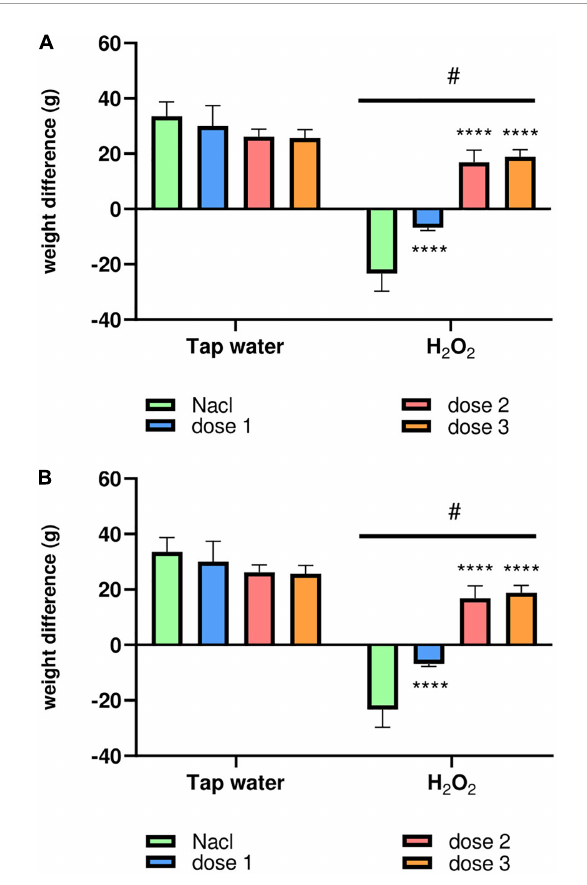
FIGURE3 The animals’ body weight variation during the test period. (A) The kinetics of the average body weight of the different groups of animals weighed every 5 days of the treatment period. (B) The average body weight intake of all the animal groups between the first and the last day of treatment. The results were presented as mean ± SD ( n = 6). Data were analyzed by Two-ways ANOVA followed by Bonferroni’s post-hoc test; **** p ≤ 0.0001 compared to saline group in the same treatment conditions. (#) in comparison with the control group (group 1).